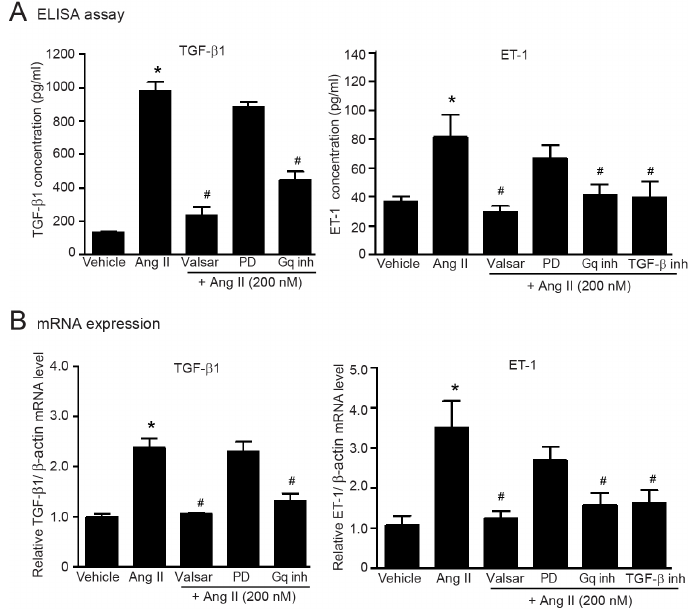
Figure 5. Ang II induces the secretion and synthesis of TGF- β 1 and ET-1 via the AT 1 R/G α q axis in adult HCFs. Serum-starved adult HCFs were incubated with valsartan (valsar; 1 µ M), PD123319 (1 µ M), FR900359 (G α q inh; 1 µ M), or LY2109761 (TGF- β inh; 5 µ M) for 1 h before stimulation with 200 nM Ang II for 24 ( A ) or 6 h ( B ). ( A ) After Ang II treatment, the culture medium was collected. The amounts of TGF- β 1 and ET-1 secreted into the culture medium were determined by ELISA. ( B ) Relative mRNA levels of TGF- β 1 and ET-1 were analyzed by qRT-PCR. Data are expressed as the mean ± SEM ( n = 4). * p < 0.05 vs. vehicle; # p < 0.05 vs. Ang II.